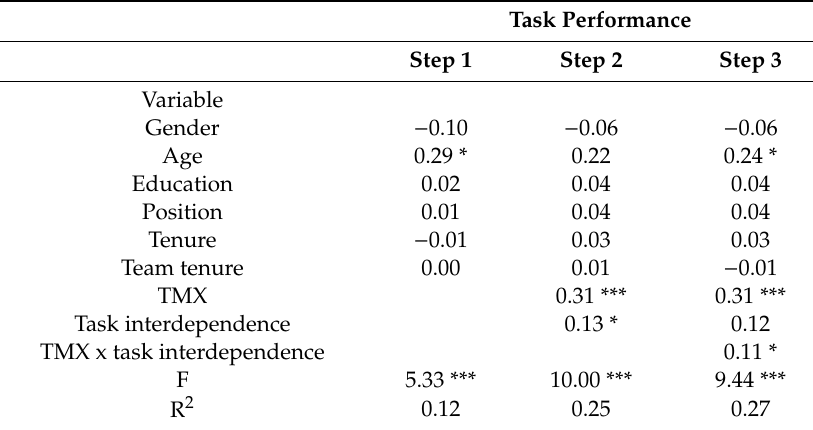
Table 3. Regression results for moderation.